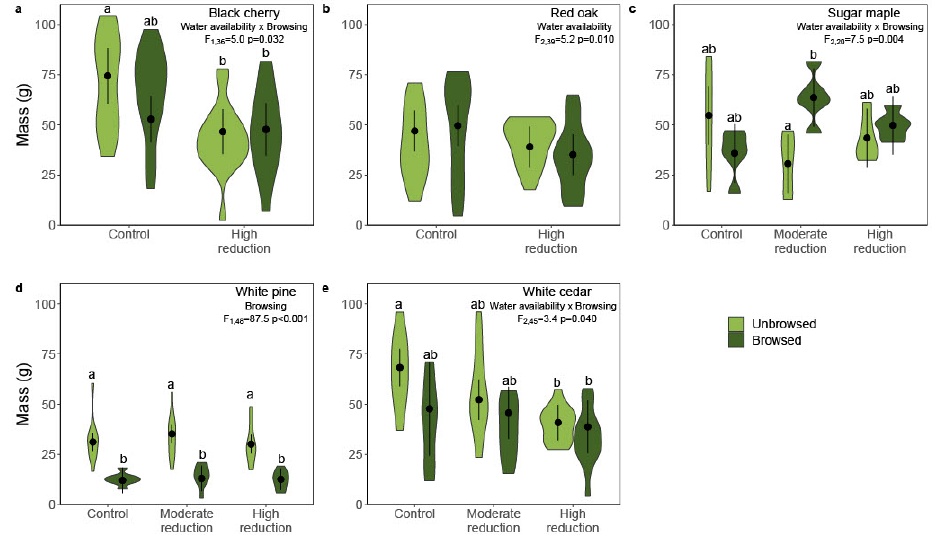
Figure 2. Differential effect of simulated winter browsing and reduced water availability on total mass of five seedling’s species from a greenhouse experiment. Dry mass ( 𝑥̅ ± 95%CI of model estimates) of ( a ) black cherry ( Prunus serotina Ehrh.); ( b ) northern red oak ( Quercus rubra L.); ( c ) sugar maple ( Acer saccharum Marsh.); ( d ) white pine ( Pinus strobus L.); ( e ) white cedar ( Thuja occidentalis L.). We measured the dry mass after ten weeks of growth under two or three levels of water availability reduction (control: 80% of pot capacity; moderate reduction: 50%; high reduction: 25%). We used a linear mixed model with a random effect of blocks ( n = 5) to evaluate the effect of treatments on mass. To account for differences between the initial mass of seedlings, height at the beginning of the experiment and its interactions were included as a covariate in the model. Different letters indicate a posteriori least square mean differences performed on either simulated browsing or water stress treatment or both ( α = 0.05). Violin shapes represent the distribution of the data.